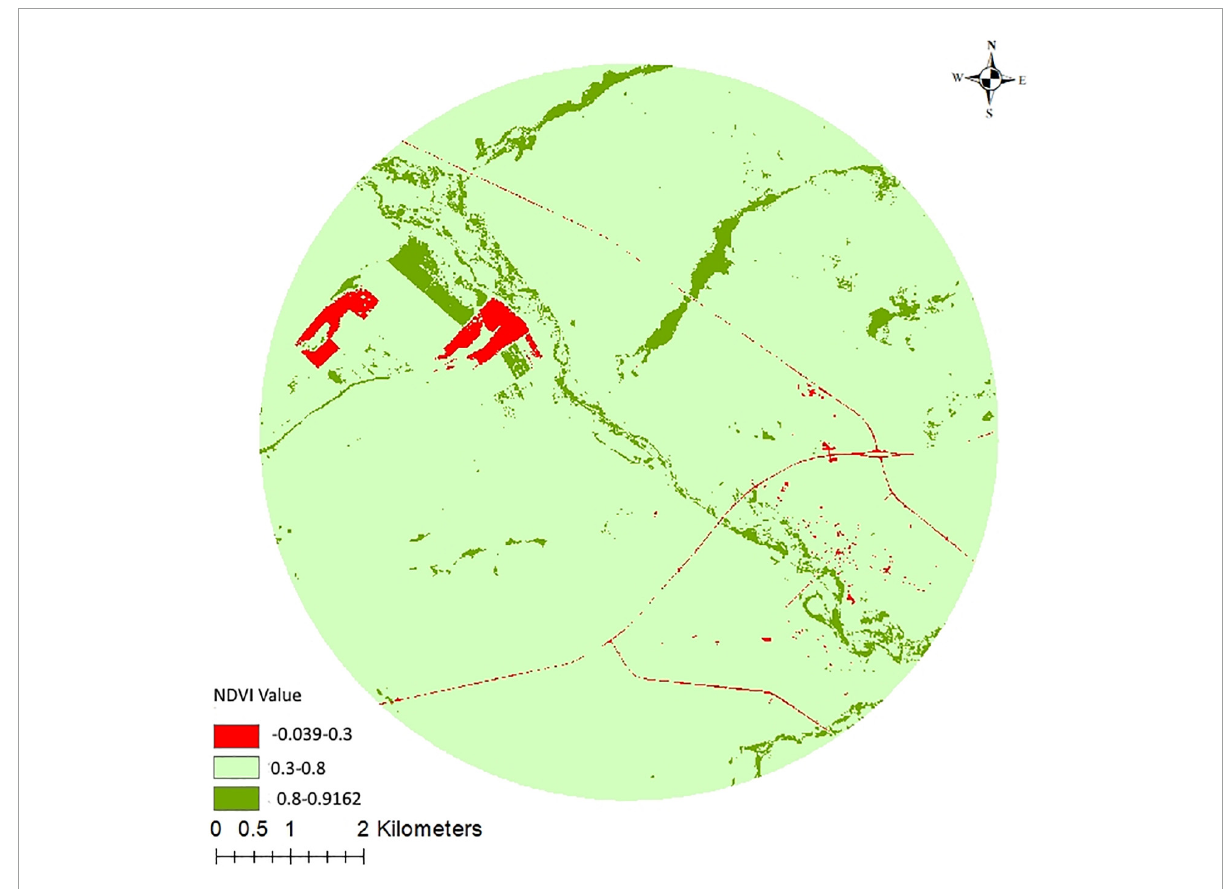
FIGURE6 NDVI of 5 km radius survey area from August 2017 Sentinel-2 image.